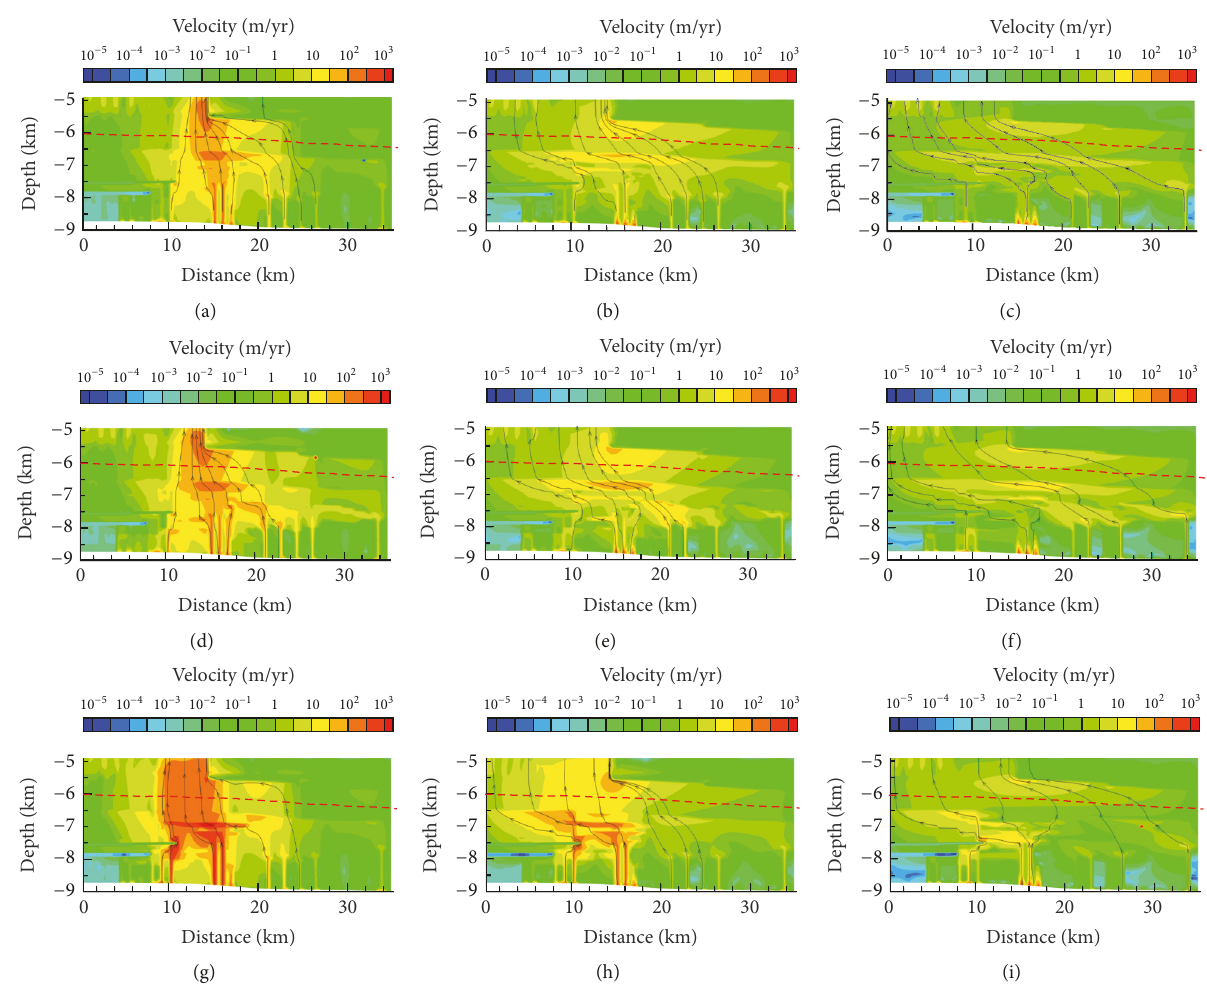
Figure 11: The fluid velocity for Scenario I: (a) 𝑘 h : 𝑘 v = 1 , (b) 𝑘 h : 𝑘 v = 10 , and (c) 𝑘 h : 𝑘 v = 100 , Scenario II: (d) 𝑘 h : 𝑘 v = 1 , (e) 𝑘 h : 𝑘 v = 10 , and (f) 𝑘 h : 𝑘 v = 100 , and Scenario III: (g) 𝑘 h : 𝑘 v = 1 , (h) 𝑘 h : 𝑘 v = 10 , and (i) 𝑘 h : 𝑘 v = 100 . The arrow lines indicate the general pathways of fluids. Note the model domains below the dashed lines which were arranged for plotting dissolved porosity in Figure 15.